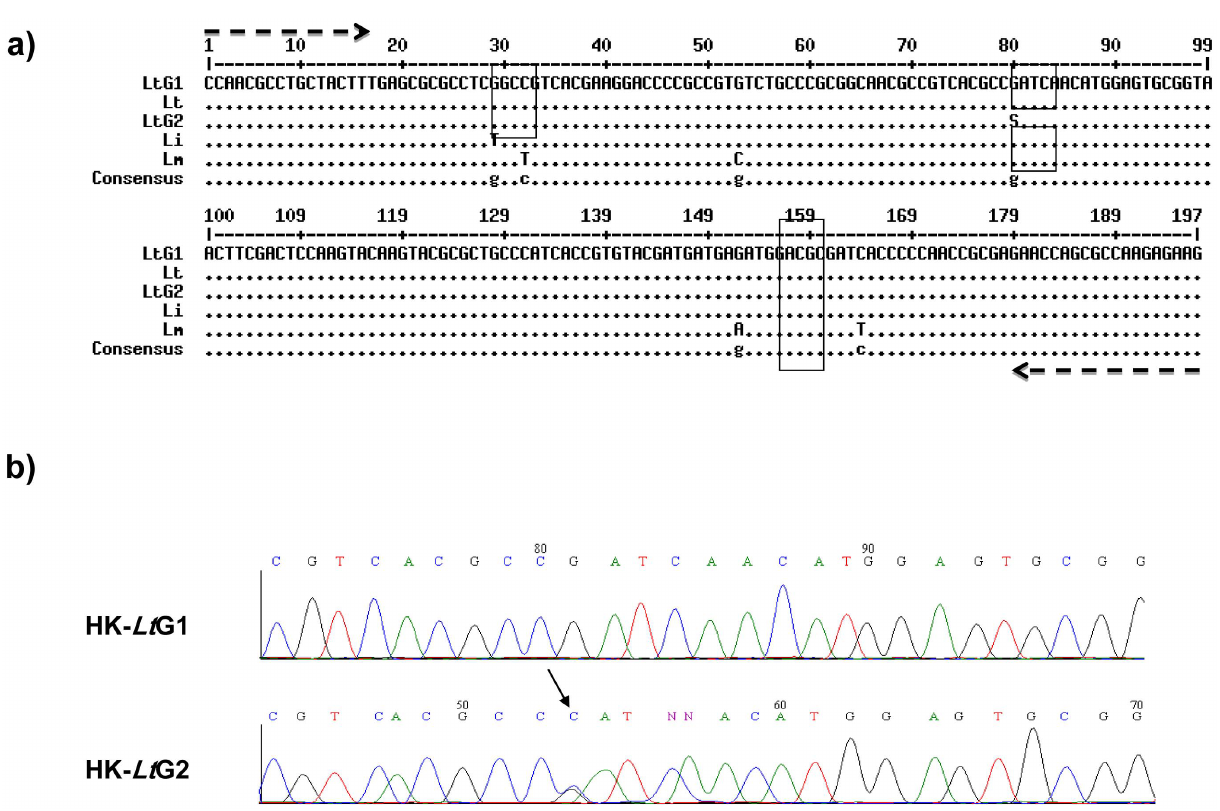
Figure 1. a) Alignment of the HK nucleotide sequences of the strains of Leishmaniatropica , L.major and L.infantum : cleavage sites of endonucleases MboI and HaeIII are ‘boxed’ in the HK sequence of the strains of L.tropica : HK- Lt G1= L.tropica genotype 1 derived from strain ISER/IL/1998/LRC-L758; Lt= L.tropica DNA sequence, accession number=AY635845.1; HK- Lt G2= L.tropica genotype 2 derived from strain MHOM/PS/2002/52JnYM18 (=LRC-L890) Li= L. infantum , accession number=AY632240.1; Lm= L. major , accession number=FR796417.1. Arrows indicate positions of HK forward and reverse primers. b) Electropherograms of the sequences bestowing the L. tropica genotypes 1 and 2, HK- Lt G1 and HK- Lt G2, respectively. The pinpointed ( Q ) C at the bp 80 shows a double peak for (G–C) in the HK- Lt G2 electropherogram and should have been denoted by an S instead of the C. NN in the HK- Lt G2 electropherogram indicates (C) and (A) nucleotide,